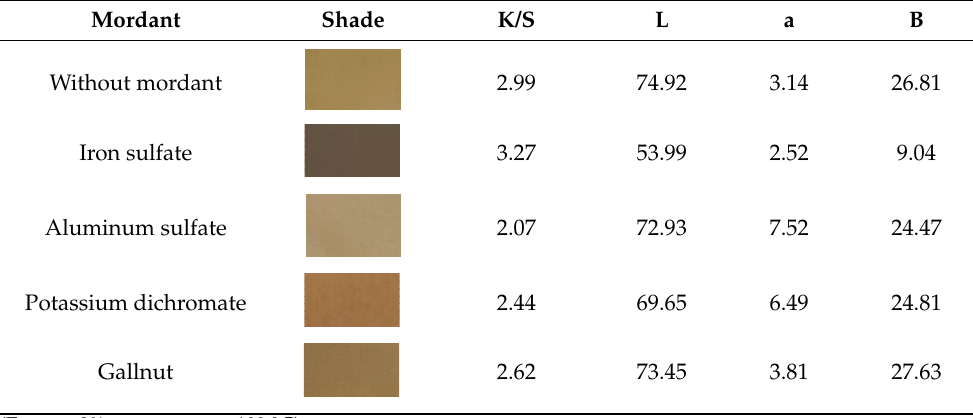
Table 4. Shades and colorimetric data obtained for polyamide fabrics. Mordant Shade K/S